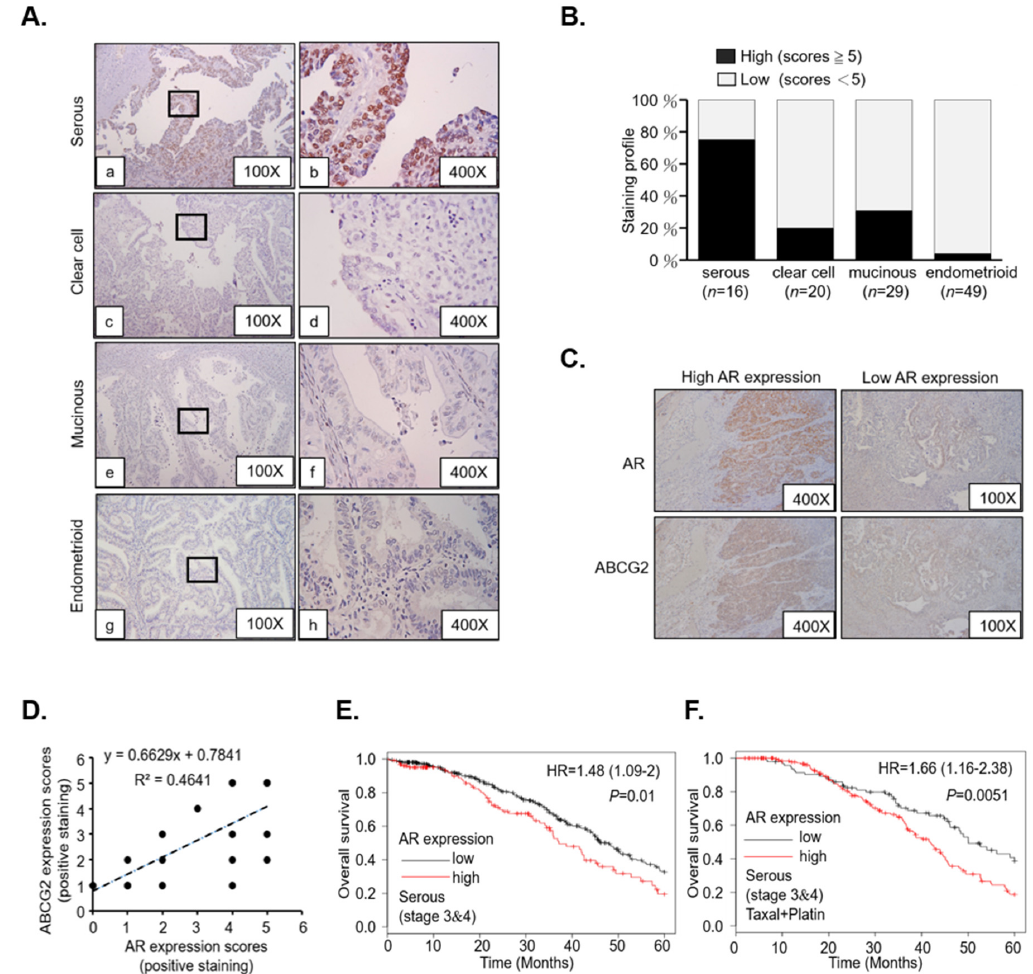
Figure 3. AR expressed predominantly in the serous EOC patients and is associated with ABCG2 expression and poor prognosis. All patient tissue blocks were selected by a pathologist from a China Medical University Hospital (CMUH) cohort, and IHC staining was performed using AR antibody. ( A ) IHC staining was performed using AR antibody. The expression of AR in different EOC subtypes is shown. EOC serous subtype (a,b) presented a higher expression of AR than the clear-cell subtype (c,d), mucinous subtype (e,f), and endometrioid subtype (g,h). ( B ) Demography of AR IHC staining scores related to EOC subtype patients. Two independent slide reviewers scored the slides. The scores were totaled from a reading of positive staining (1~5 point) plus a reading of intensity staining (1~5 point). A total score <5 was defined as low expression, while a total score ≥ 5 was defined as high expression. ( C ) IHC staining revealed AR relation to ABCG2 expression in EOCS serous subtype patient tissues. Patient tissue blocks were divided into low or high AR expression and sliced by serial dissection. IHC staining was performed using AR and ABCG2 antibody (the distribution of AR and ABCG2 were indicated by a brown color). ( D ) IHC staining scores of AR and ABCG2 show a significant positive correlation. The staining distributions for AR and ABCG2 were graded using a five-point scale according to the percentage of positive staining (0: <1%; 1: 1–20%; 2: 20–40%; 3: 40–60%; 4: 60–80%; 5: 80–100%). The staining scores were then summed and showed a distribution correlation between AR and ABCG2 expression. The statistical analysis of AR expression associated with the survival rates for the EOC subtypes was performed using the KM plotter database (http://kmplot.com/analysis/). ( E ) Serous subtype patients (at stage 3 and 4) who had a higher expression of AR were associated with a lower overall survival rate ( p = 0.01) at five years. ( F ) Serous subtype patients (at stage 3 and 4) with a higher expression of AR and taxel and platin treatments were associated with a much lower overall survival rate ( p = 0.0051) at five